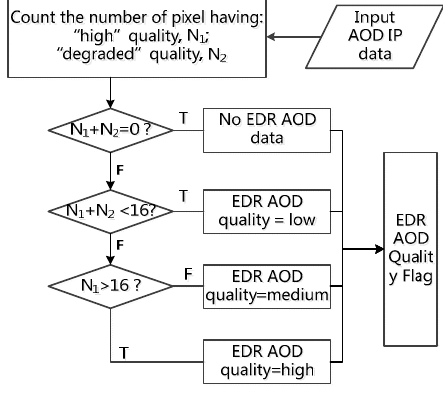
Figure 3. IP to EDR aggregation flow chart.